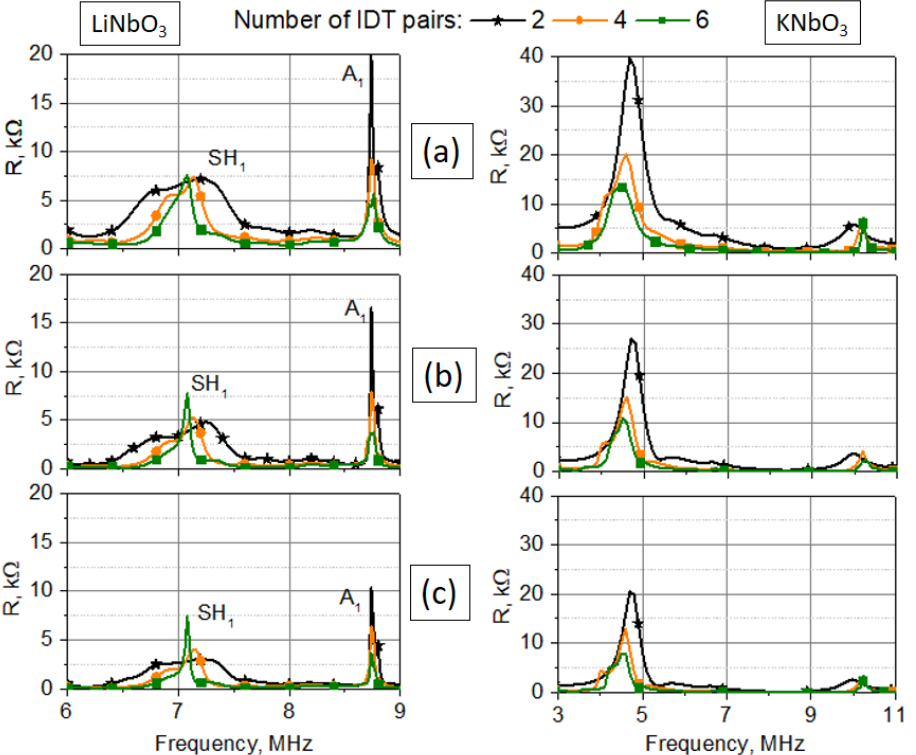
Fig. 2. Frequency dependencies of the real part of IDT impedance at different amount of pairs of IDT strips and aperture: (a) 2 mm, (b) 4 mm и (c) 6 mm for YX LiNbO 3 and KNbO 3